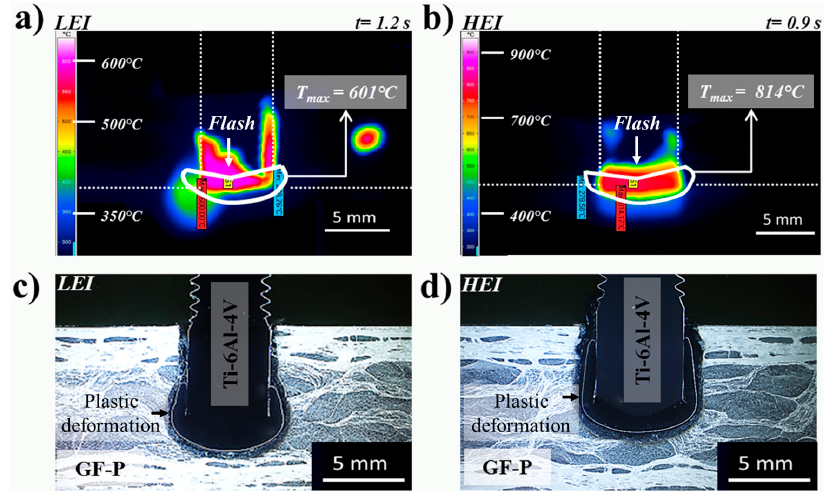
Figure 9. Infrared thermographs showing the peak process temperature ( T max ) and flash material for ( a ) LEI and ( b ) HEI conditions. Cross-sectional view of ( c ) LEI and ( d ) HEI Ti-6Al-4V/GF-P joints showing the plastic deformation of the rivet tip.